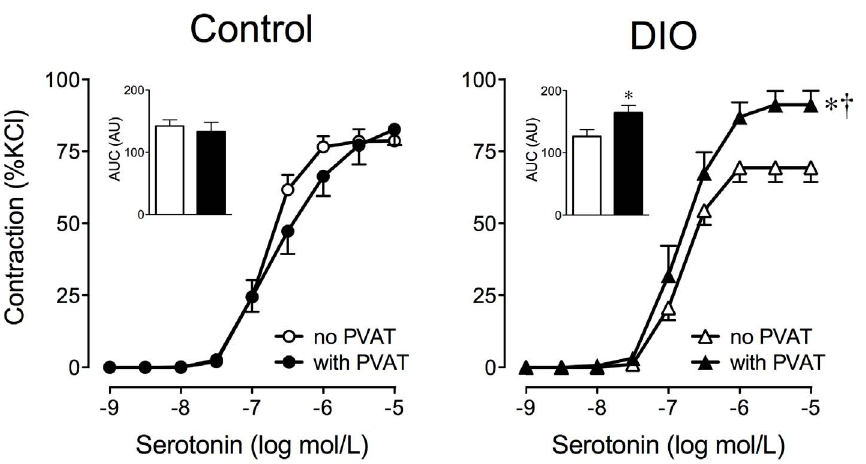
Figure 4. Effect of perivascular adipose on serotonin-induced contractions in mice with diet-induced obesity. Aortic rings with and without perivascular adipose (PVAT) from WT mice with diet-induced obesity (DIO) or lean WT mice (control) mice were exposed to increasing concentrations of serotonin. DIO animals were fed a high-fat diet for 24 weeks and compared to age-matched mice fed a standard chow (control). Inset: Area under the curve (AUC) is expressed as arbitrary units (AU). # , control, without PVAT ( n =6); , control, with PVAT ( n =6); n , DIO, without PVAT ( n =5); m , DIO, with PVAT ( n =7). * p , 0.05 vs. aortic rings without perivascular adipose; { p , 0.05 vs. control.